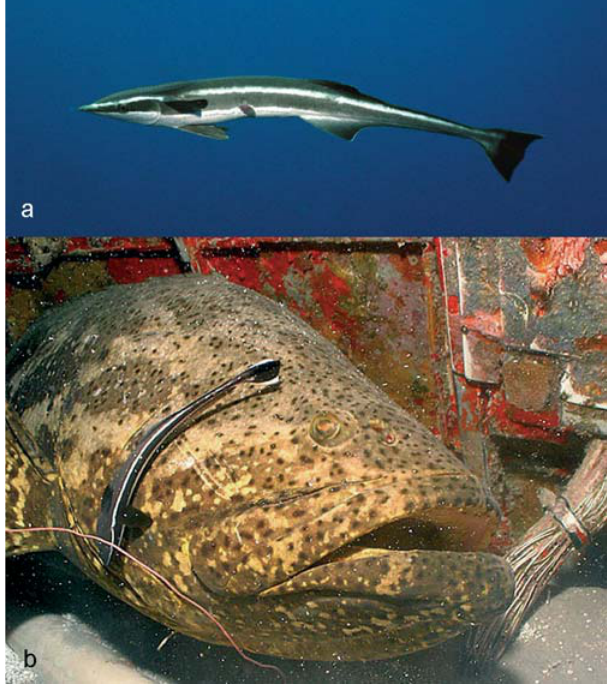
Fig. 3. A sharksucker ( Echeneis naucrates ) free-swimming in the water column (a). Photo by G. Marcovaldi. A station-based juvenile sharksucker cleaning a jewfish ( Epinephelus itajara ) in a shipwreck (b). Photo by L. B.